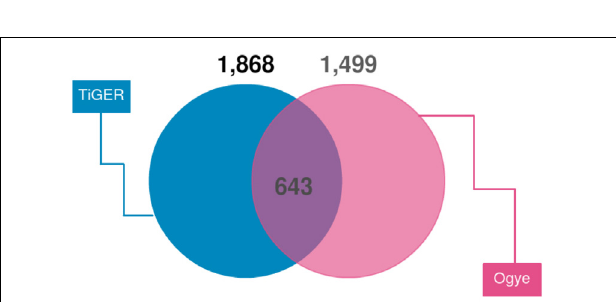
FIGURE 7 | Venn diagram of TSGs intersecting with human TSGs (TiGER database). TiGER database genes were selected with paralog genes of the chicken gene annotations. Only single copy genes were